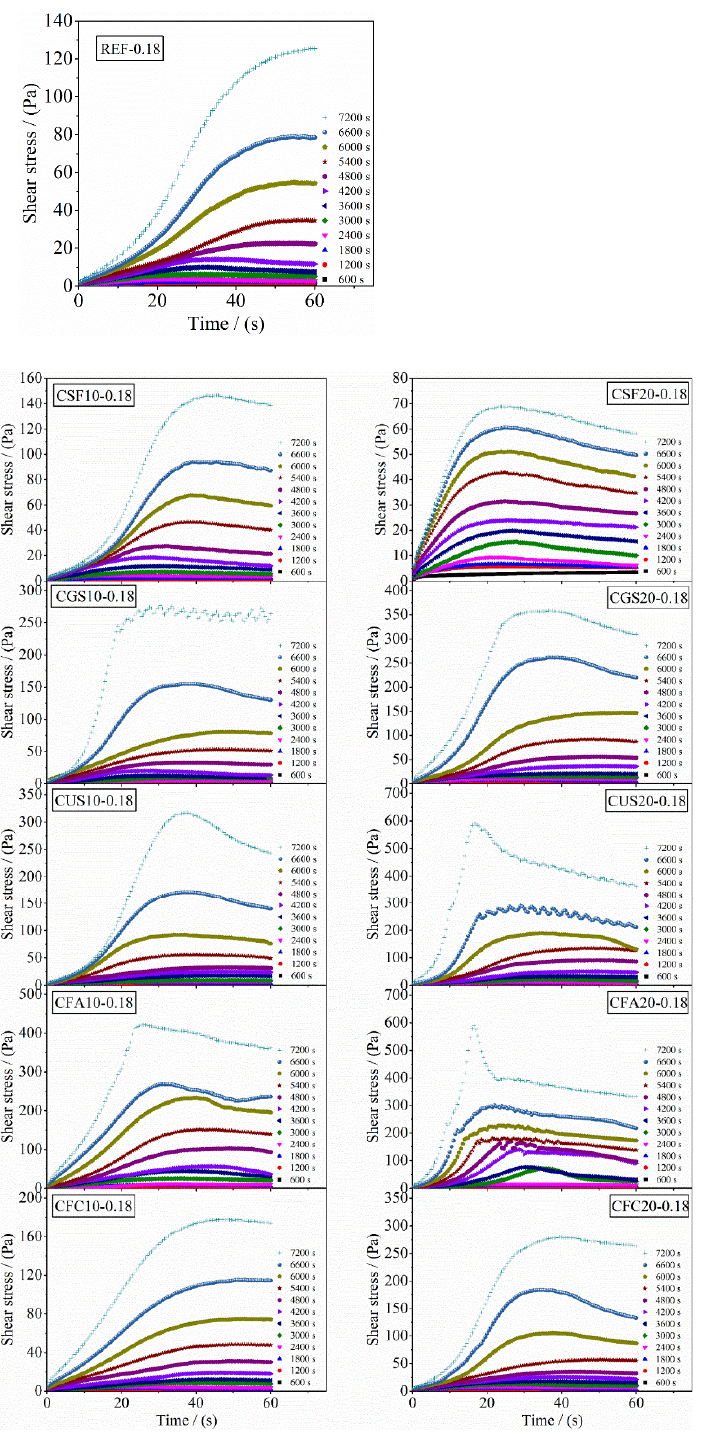
Figure 11. The change of shear stress of UHPC-based pastes with time at each test stage.